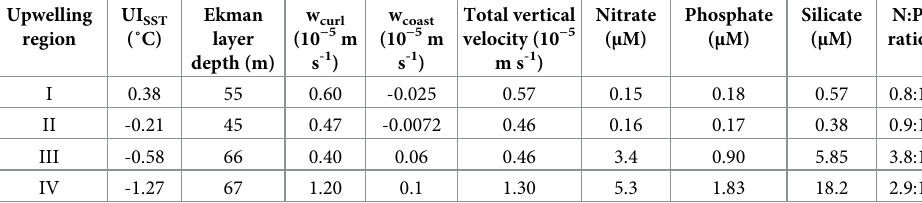
Table 2. Mean SST upwelling index, Ekman layer depth, vertical velocity of curl-driven upwelling, vertical velocity of coastal upwelling, total vertical velocity, and nutrients concentrations extracted at a depth: ~20m in both I and II and depth: ~140m at III and IV at the upwelling regions during the summer season (June, July, August). Ekman layer depth and vertical velocity are derived from the monthly climatology of wind datasets which are extracted from the ECMWF(ERA5) datasets for the year 2018. ERA5 Climatologies have been calculated over the long-term aver- age period of 1981–2010. Whereas nutrient’s data are downloaded from the monthly climatology of the WOA data for the year 2018. The WOA data are climatological data collected from the periods